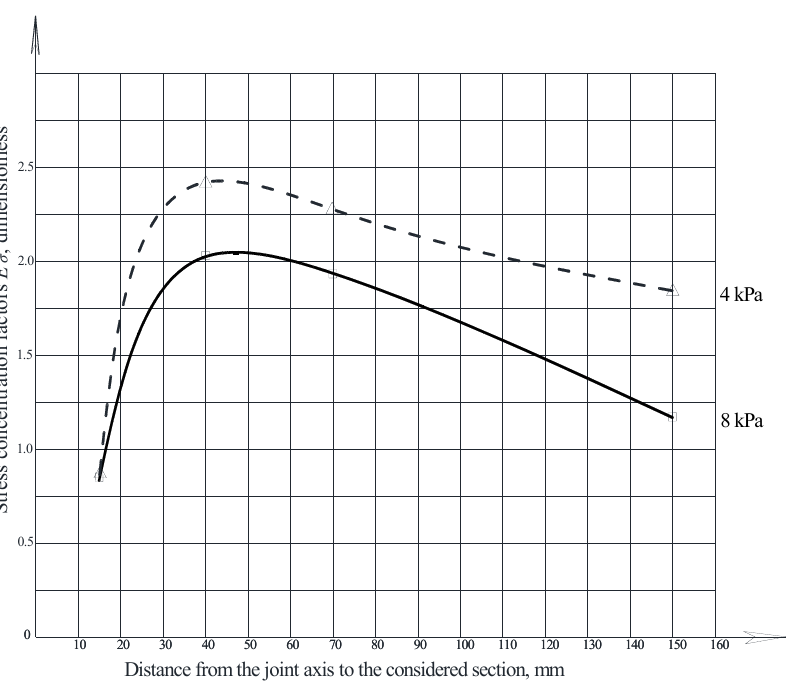
Figure 10. The meridional stress concentration in the field joint zone of the wall with a bend of 30 mm in section C-3.